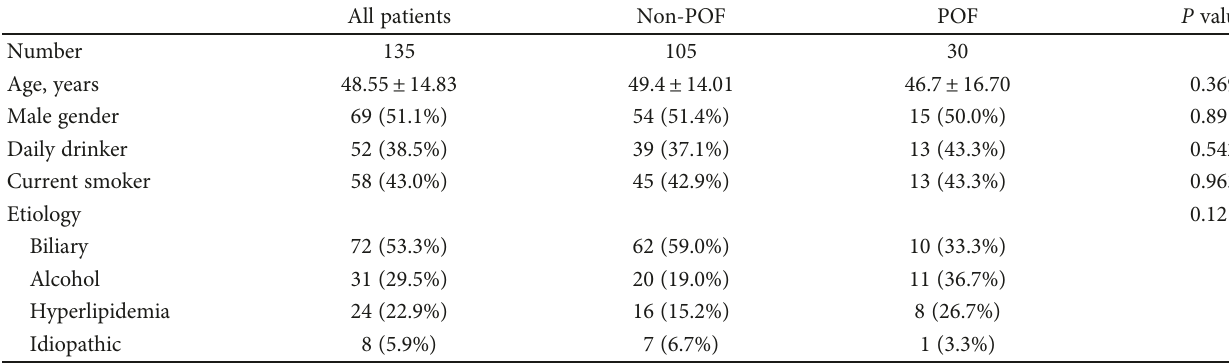
Table 3: Demographic and clinical characteristics of the patients with and without POF.